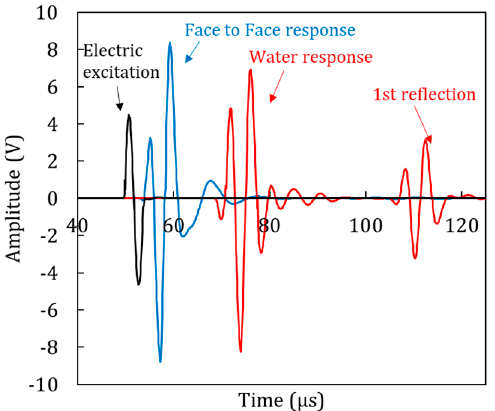
Figure 3. Recorded waveforms during ultrasonic investigation (electric, face-to-face “FtF” sensors’ response, water response).